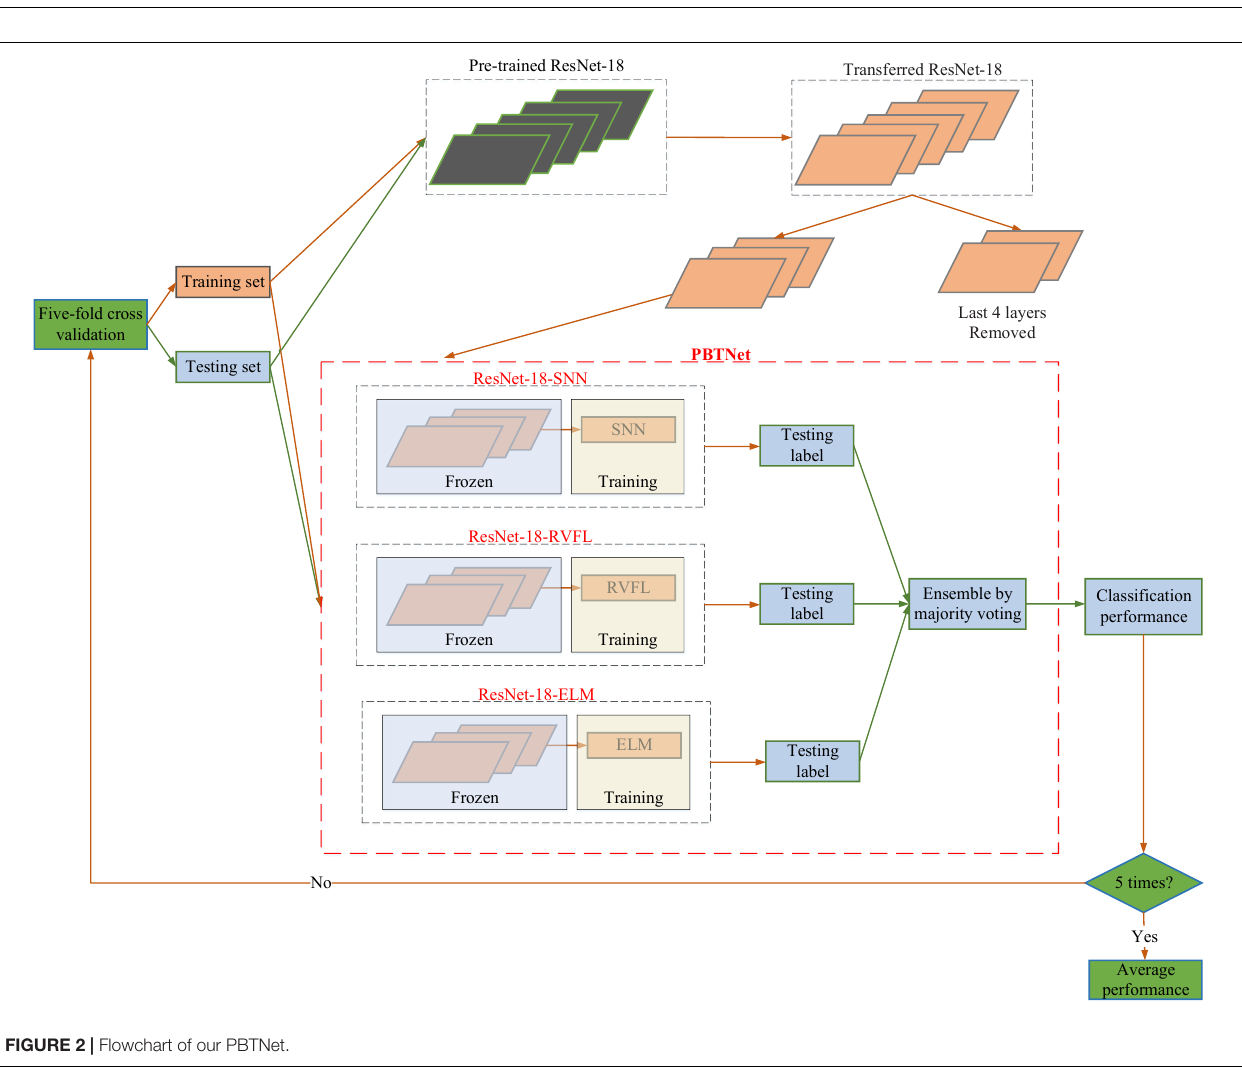
FIGURE 1 | MRI slices in our dataset (A) Primary brain tumor samples. (B) Non-tumor samples.